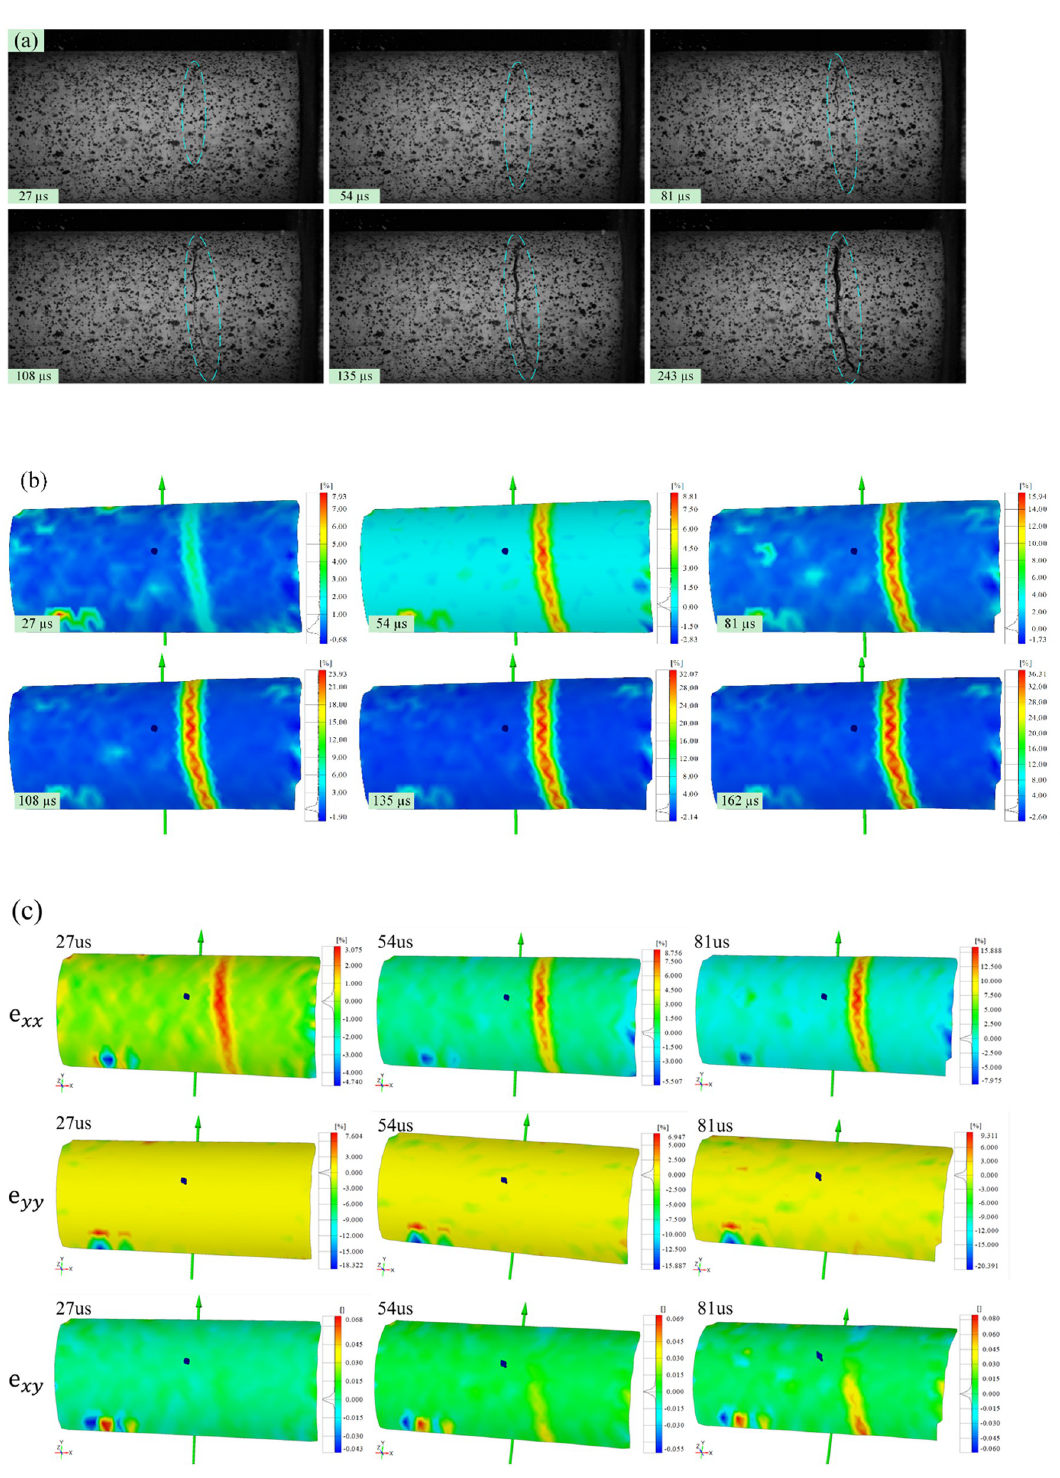
Fig 4. Images of the evolution of visible cracks and strain fields in different directions at a velocity of 20.0 m/s (the right face is the impacting face). (a) the high-speed images; (b) the maximum principal strain; (c) the axial (e xx ), vertical (e yy ) and shear (e xy )